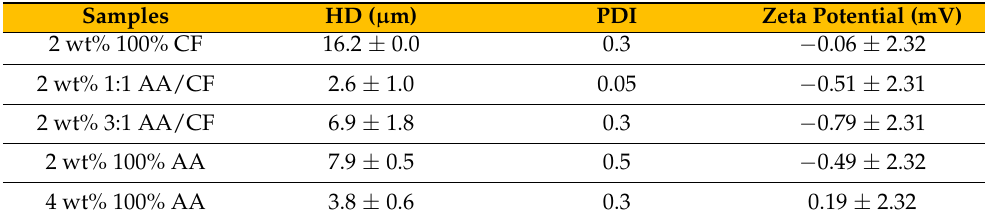
Figure 4. Dynamic light scattering (DLS) size distribution by intensity (%) of ( a ) 2 wt% 100% CF, ( b ) 2 wt% 1:1 AA/CF, ( c ) 2 wt% 3:1 AA/CF, ( d ) 2 wt% 100% AA, and ( e ) 4 wt% 100% AA, in nm. Table 3. Hydrodynamic diameters (in µm), polydispersity index (PDI), and zeta potential (mV) values of the particles for each sample.